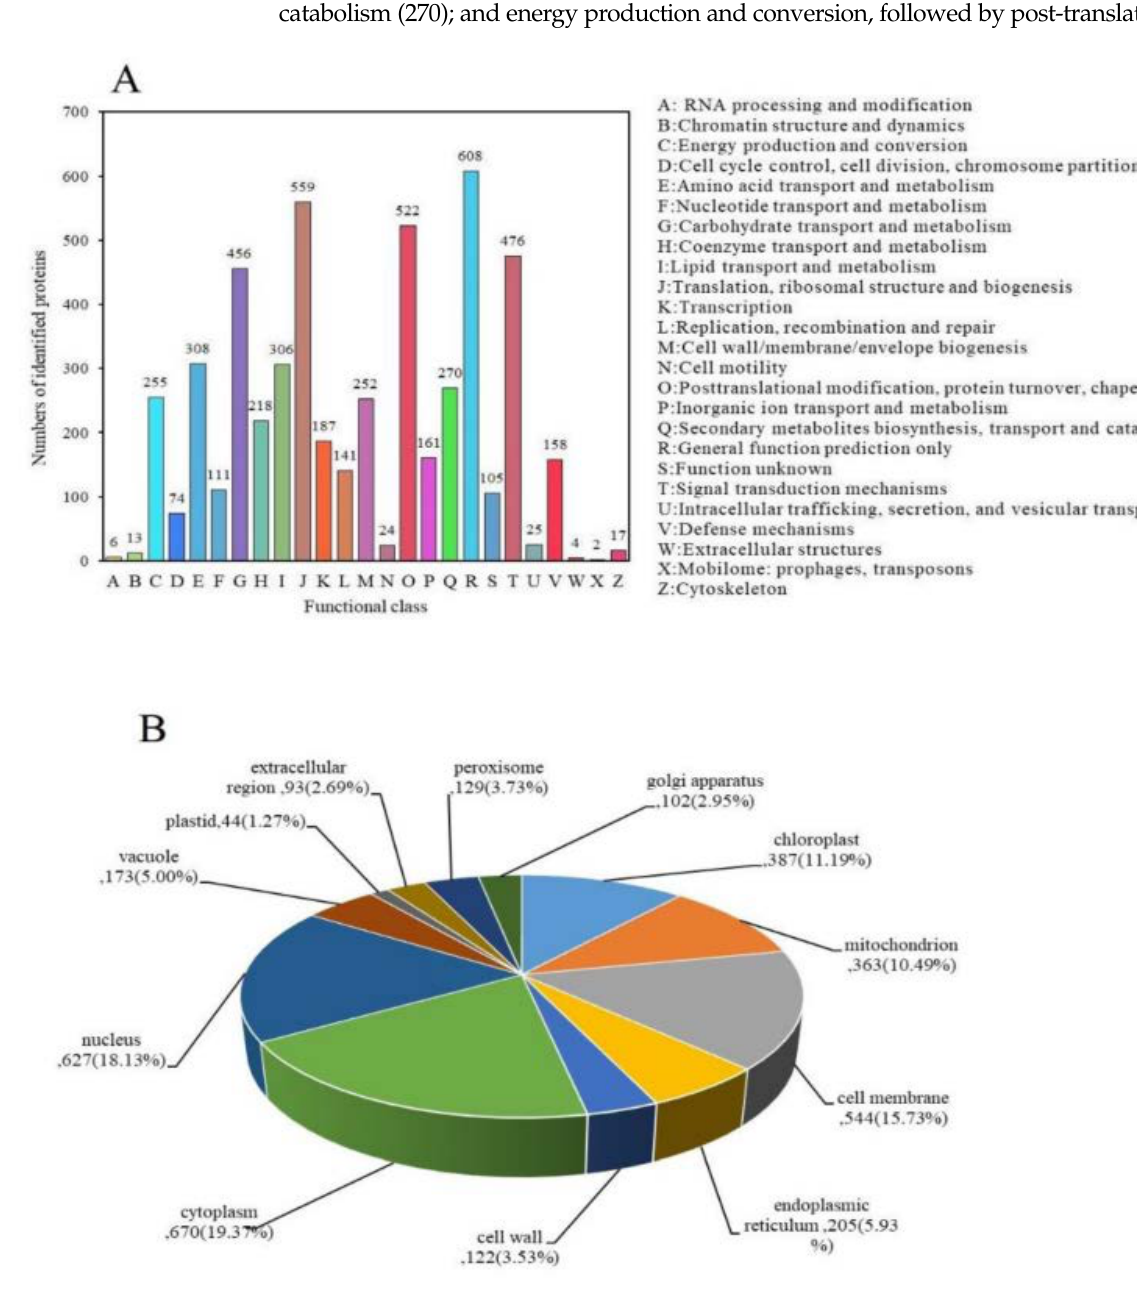
Figure 5. Categorization of all identified proteins with respect to COG annotation ( A ) and subcellular localization ( B